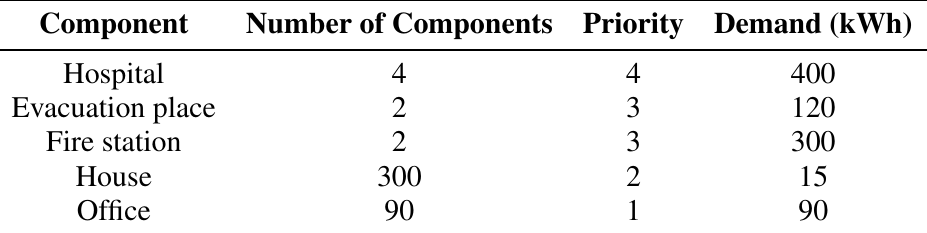
Table 1. List of loads in the simulated large-scale